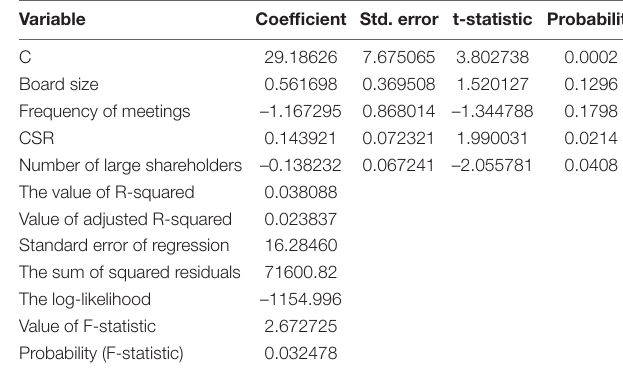
TABLE 4 | Regression analysis: descriptions dependent variable is the return on assets. Variable Coefficient Std. error t-statistic Probability